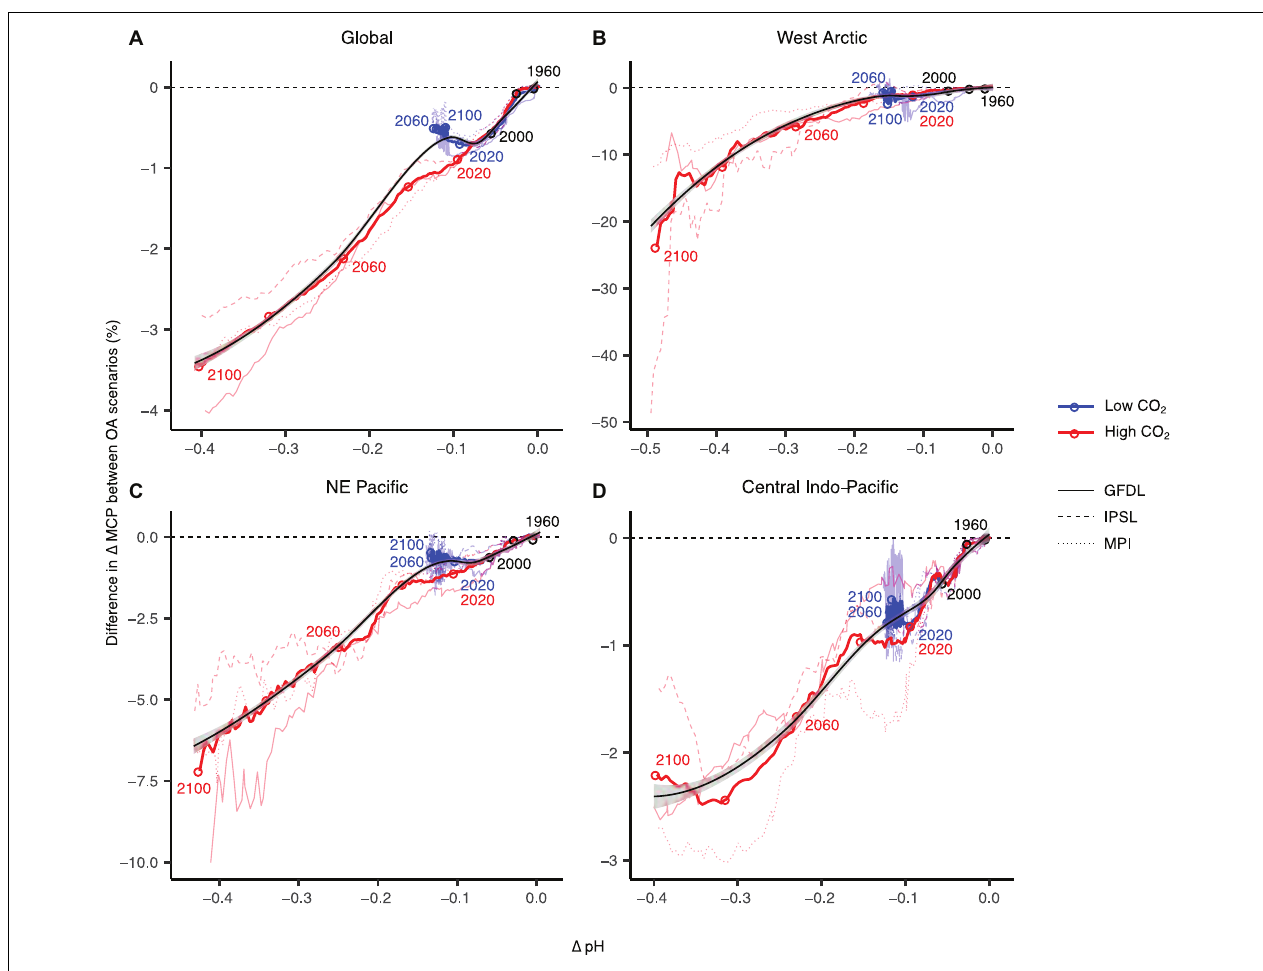
FIGURE 4 | Projected ocean acidification (OA) impacts on maximum catch potential (MCP) of marine invertebrates in addition to other climate change stressors for global (A) and other major regions (B–D) . Surface pH is used here to show the relationship between acidity and MCP. Thicker coloured lines are multi-model means and thinner lines are simulations with the different earth system models: GFDL-ESM2M; MPI-ESM-MR; IPSL-CM5A-MR. Black lines and grey bands are selected smoothed regressions and 95% confidence limits. MCP data are smoothed by a 10-year running mean and relative to